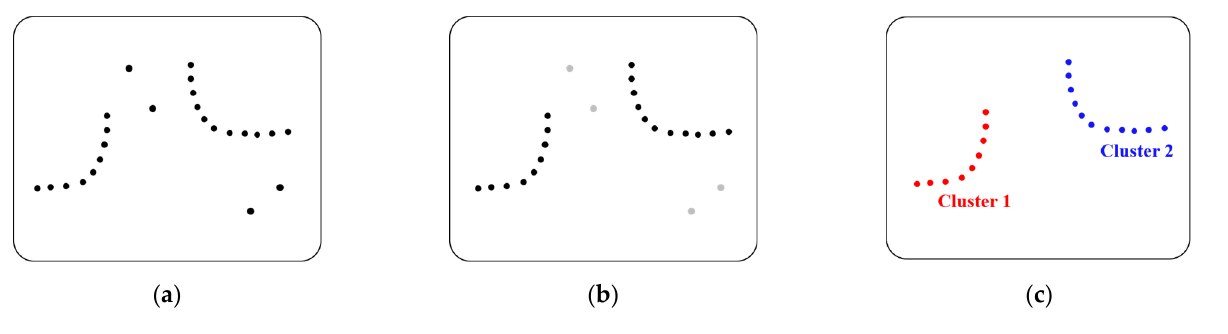
Figure 1. DBSCAN clustering: ( a ) raw data of LidAR sensor that recognized two obstacles; ( b ) data with noise removed; ( c ) data of two clustered obstacles.